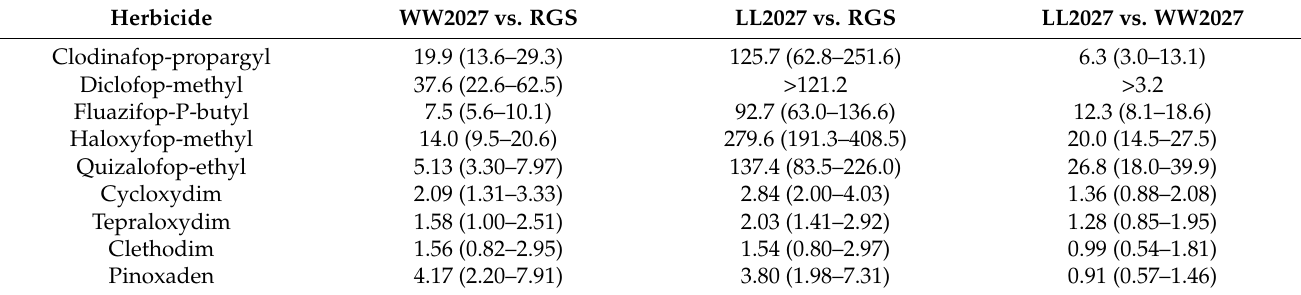
Table 3. Resistance indices estimated from the dose–response test on three genotypes: RGS (standard sensitive), WW2027 (homozygous wild-type tryptophan), and LL2027 (homozygous mutant leucine) and nine ACCase-inhibiting herbicides. Herbicide WW2027 vs. RGS LL2027 vs. RGS LL2027 vs.